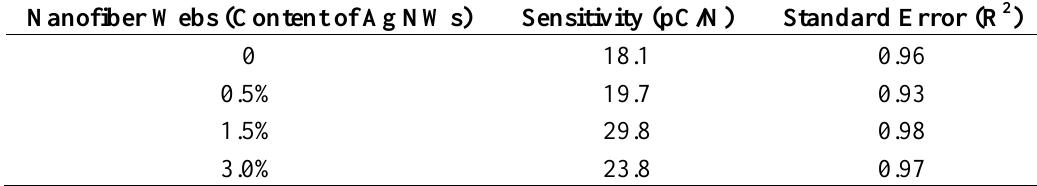
Table 1. Sensitivities of the pressure sensors based on nanofiber